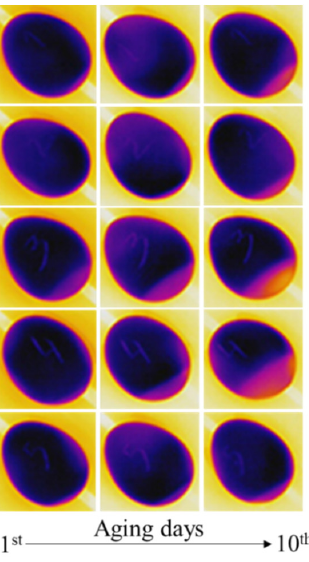
Figure 9. The aging effects on eggs after 10 days of storage under accelerated aging conditions of 28 °C and 60% humidity.